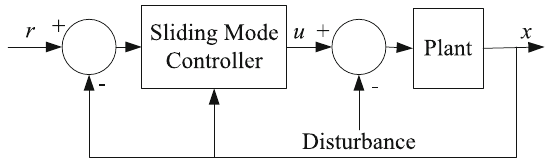
Fig. 1 Conventional feedback configuration of system